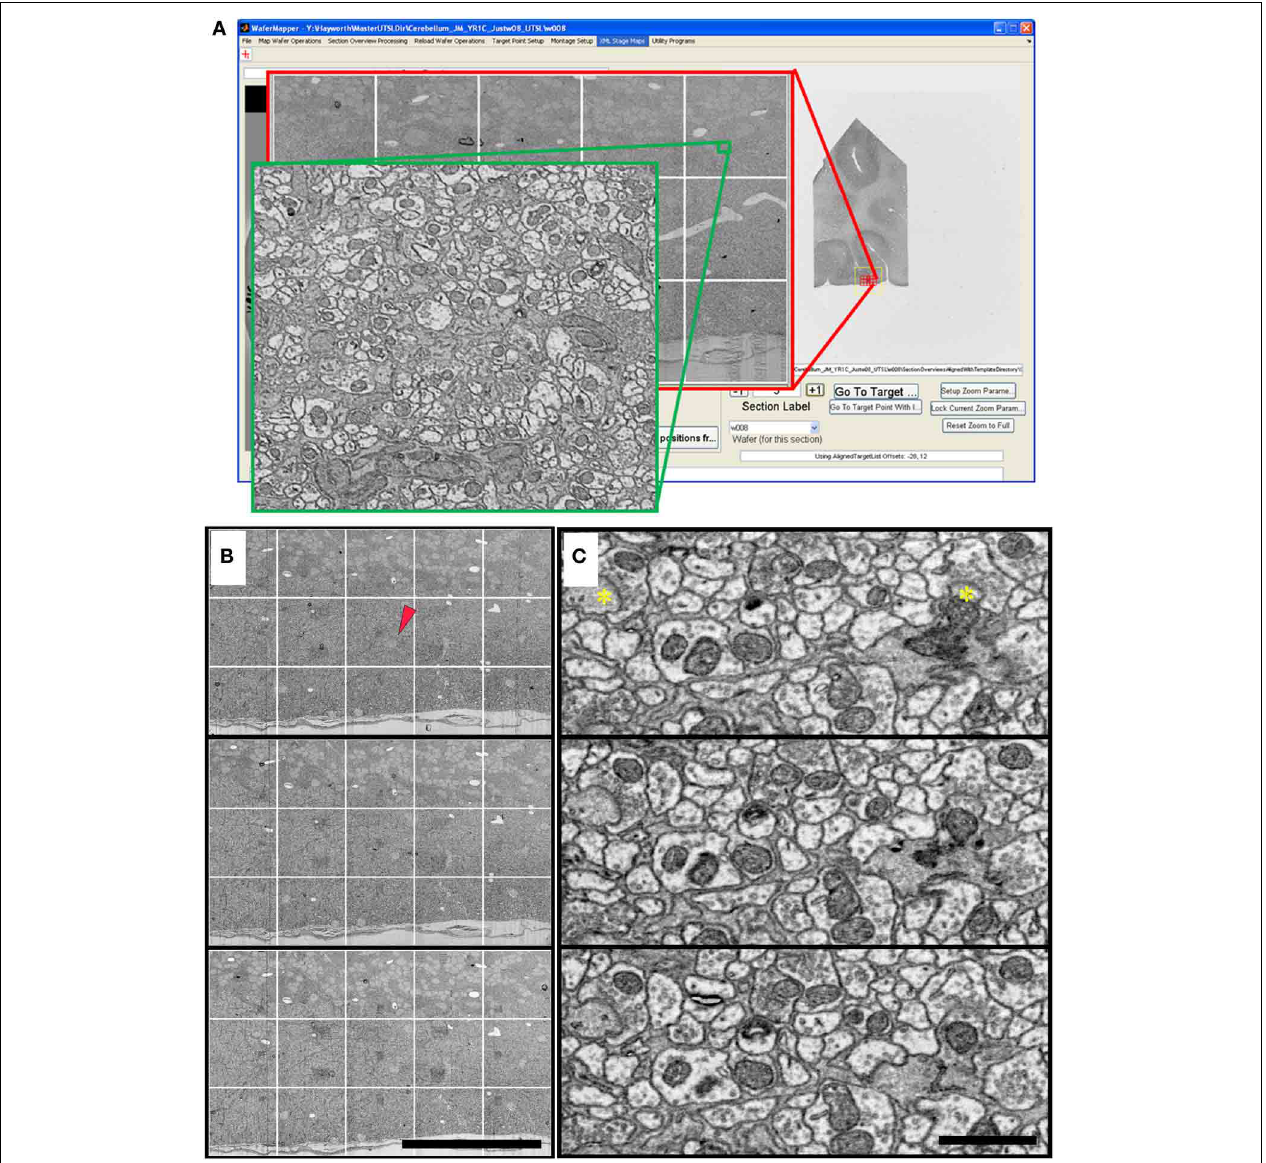
FIGURE 9 | Cerebellum UTSL example data. (A) Image of WaferMapper GUI showing a graphically-defined 3 × 5-tile montage targeted near the surface of a cerebellar folium. Zoom overlays show high resolution images of that region. (B) Montage images of three successive ultrathin sections in this